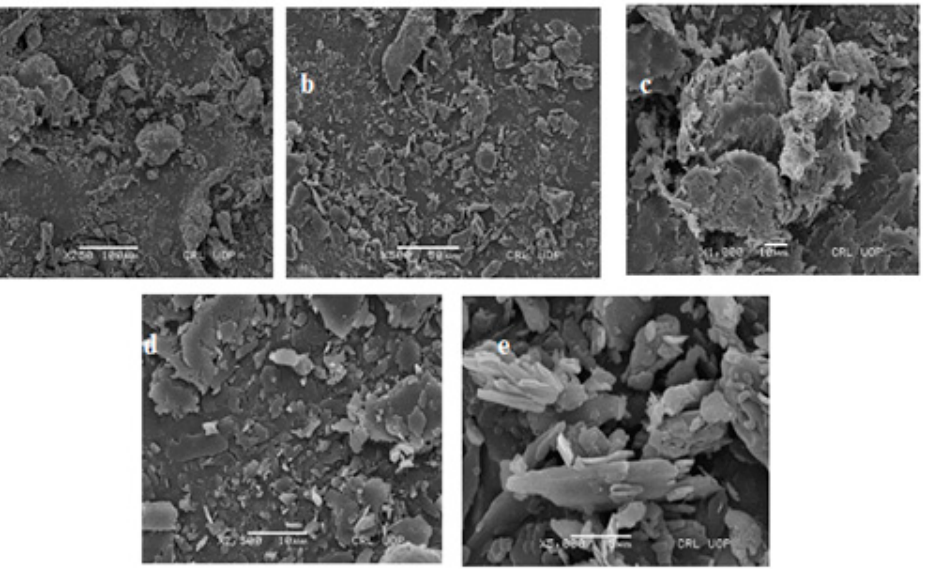
Figure 2. SEM images of F2 formulation of KA-loaded nanocrystals: ( a ) 250×, ( b ) 500×, ( c ) 1000×, ( d ) 2500× and ( e ) 5000×.